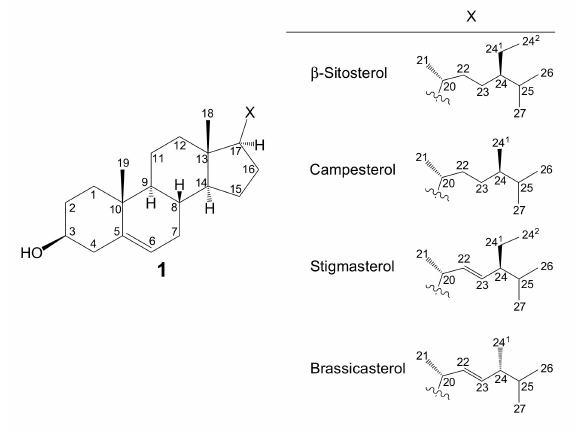
Figure 1. The structures of four phytosterols. β -Sitosterol 1 (catalog number: S0040, 25g, JPY